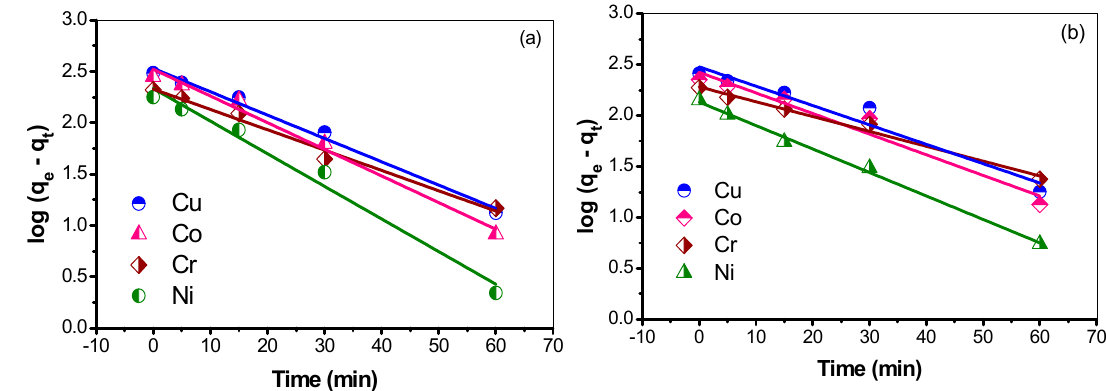
Figure 9. The kinetic character of Lagergren’s pseudo first-order on the adsorption of metal ions by the jute cellulose-based polymer ligands: ( a ) PHA and ( b ) PA ligand; experimental variables: 0.5 g of ligands (PHA or PA), 15 mL of distilled water, 5 mL of pH 6 buffer solution, 5 mL of 0.2 M synthetic metals ions solution and stirred for 2 h.